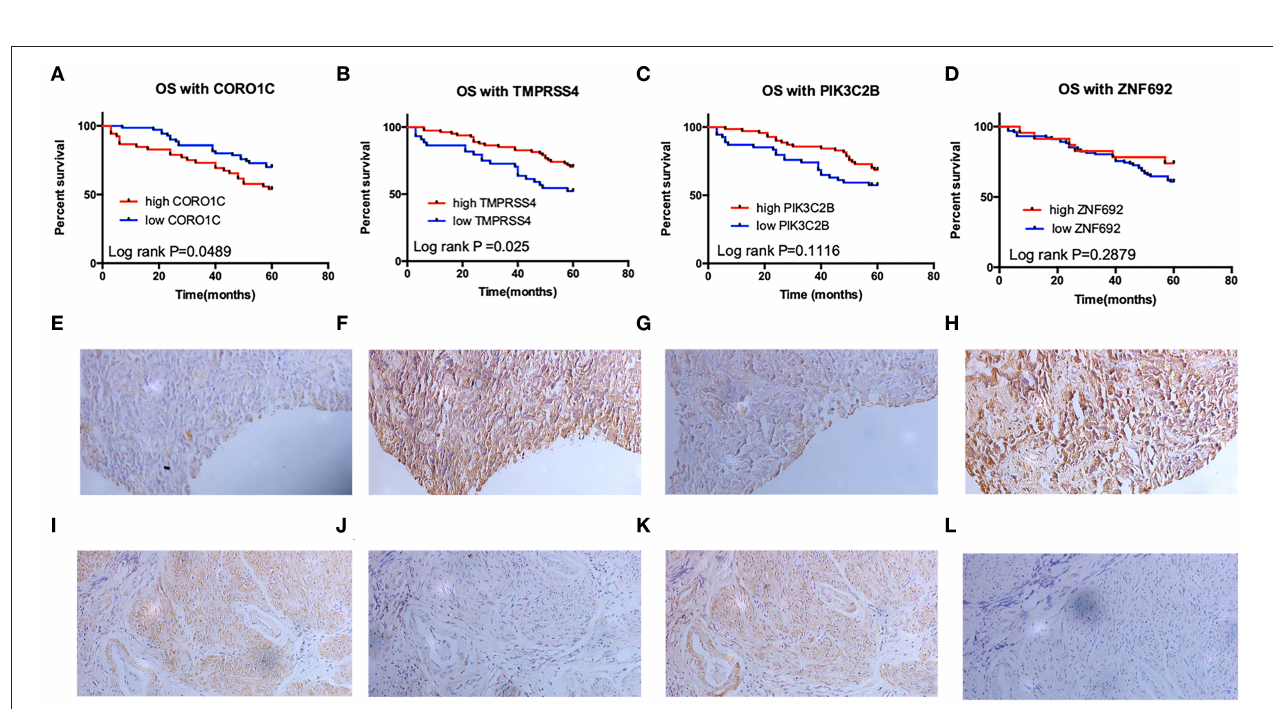
FIGURE 5 | Validation of the prognostic value of four candidate hub genes in clinical specimens. (A–D) Survival analysis of CORO1C (A) , TMPRSS4 (B) , PIK3C2B (C) , and ZNF692 (D) in 124 bladder cancer patients’ follow-up in our center. (E–L) Representative image of 200 × immunohistochemical experiment on CORO1C (E,F) , TMPRSS4 (G,H) , PIK3C2B (I,J) , and ZNF692 (K,L) clinical specimens.